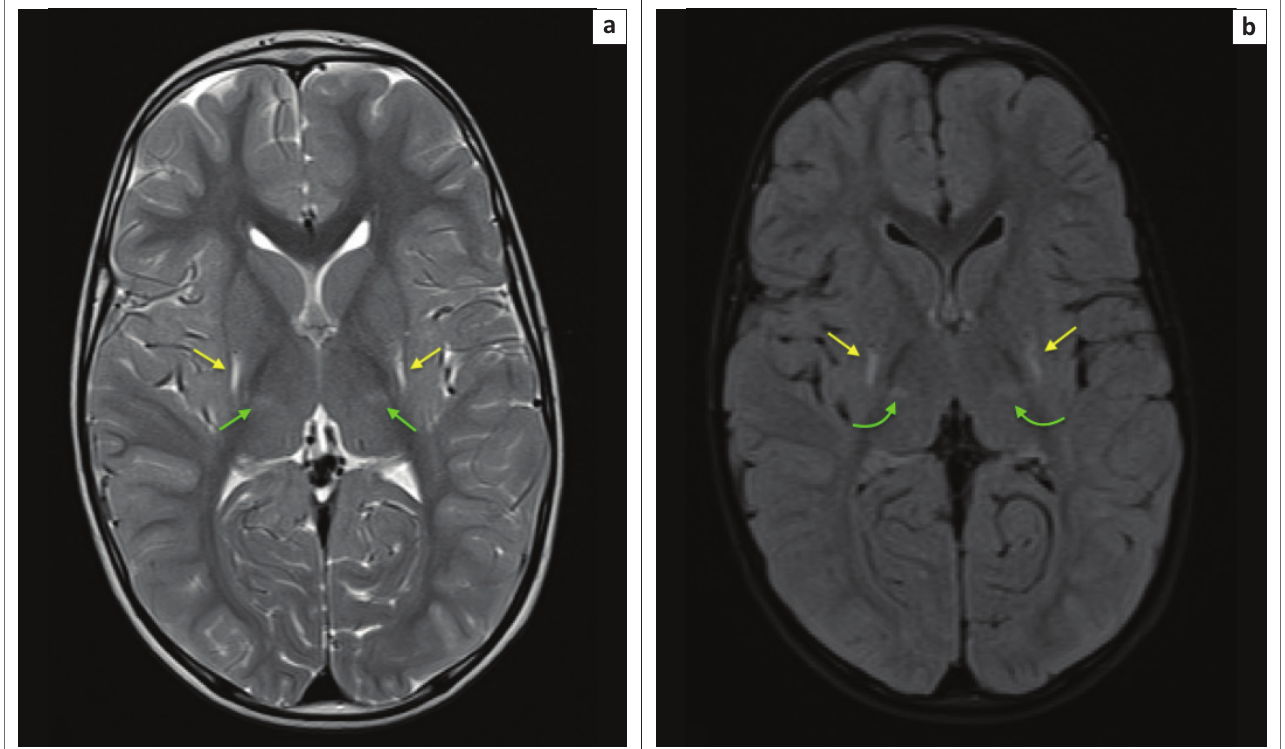
FIGURE 9: Four-year-old male child with cerebral palsy. Neonatal history of hypoxic ischemic brain injury-related encephalopathy, seizures, requiring ventilation and prolonged 4 week stay in ICU. (a) An axial T2-weighted sequence and (b) an axial FLAIR sequence image showing subtle flame shaped dorsal putaminal (yellow arrows) hyperintensity and smudge-like ventral thalamic (green arrows) hyperintensity